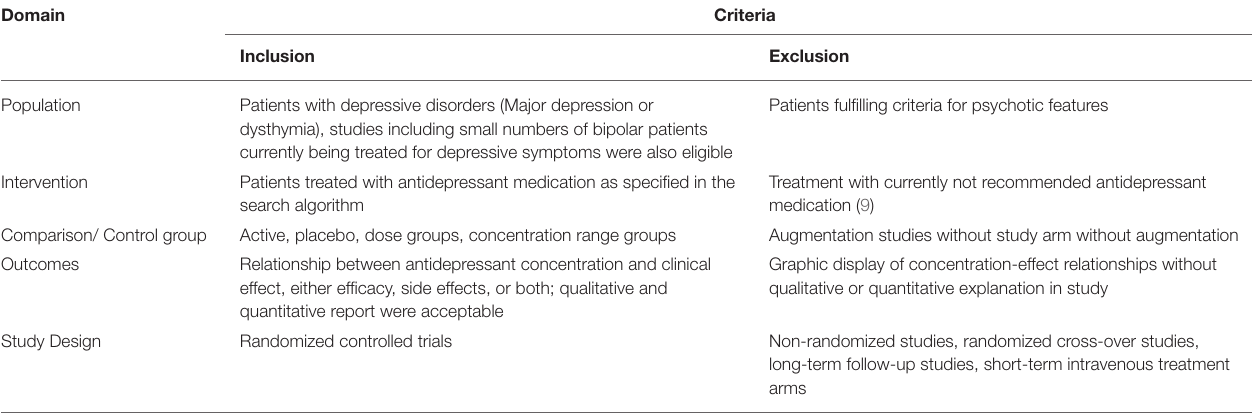
TABLE 1 | Study selection process: inclusion and exclusion criteria (PICOS). Domain Criteria